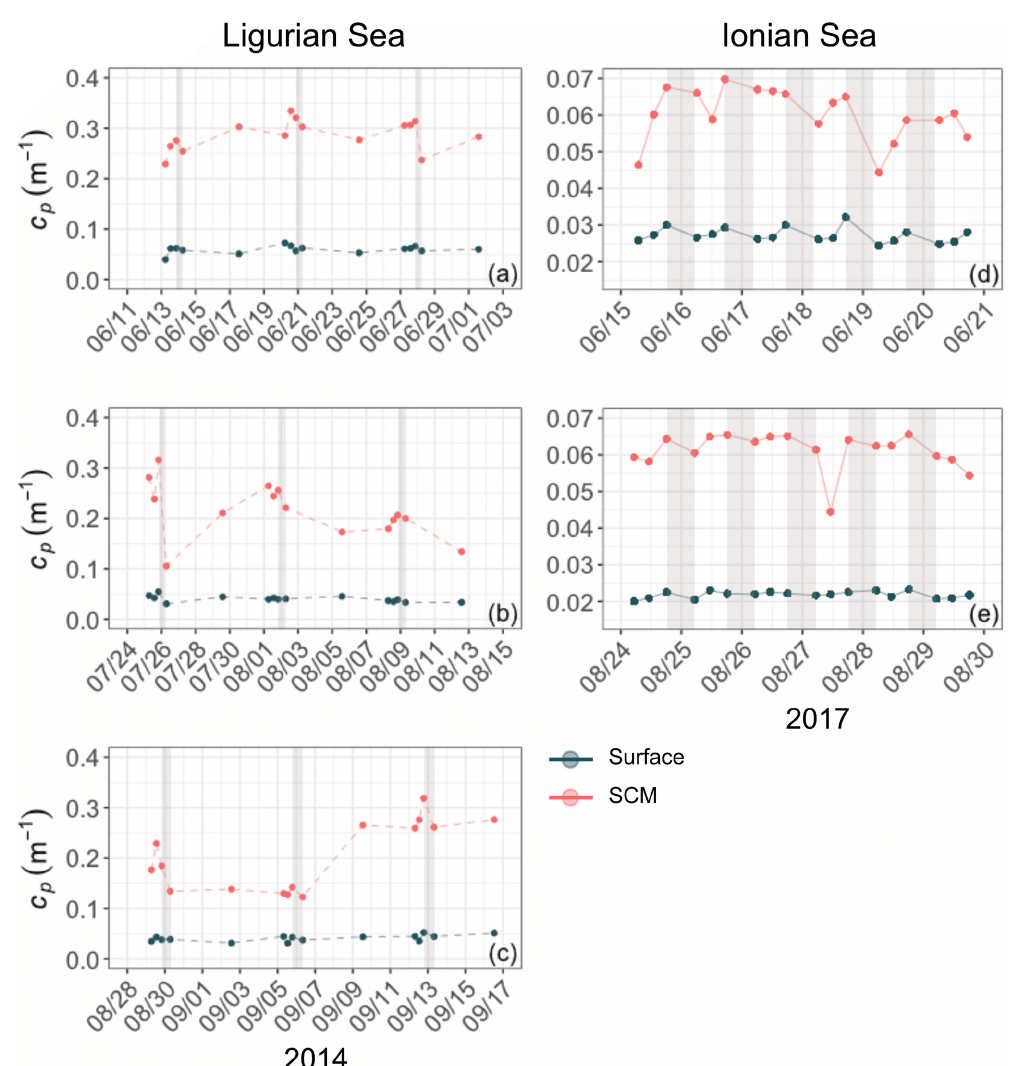
Figure A1. Example of time series of the c p coefficient in the surface (red) and SCM (dark green) layers, chosen within the time periods indicated by the dashed lines in Figs. 3–4, from 24 May to 14 July 2014 (a) , 14 July to 16 August 2014 (b) and 16 August to 13 Septem- ber 2014 for the Ligurian Sea (a–c) and from 28 May to 11 August 2017 (d) and 11 August to 11 September 2017 (e) for the Ionian Sea (d–e) . Please note that the date format in this figure is